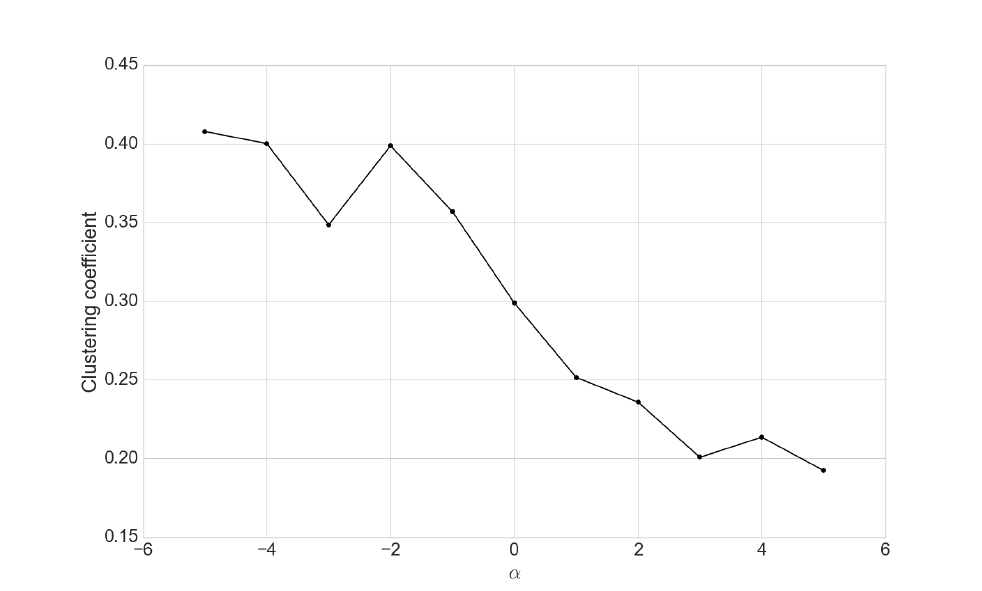
Figure 11. Risk preference α vs. average clustering